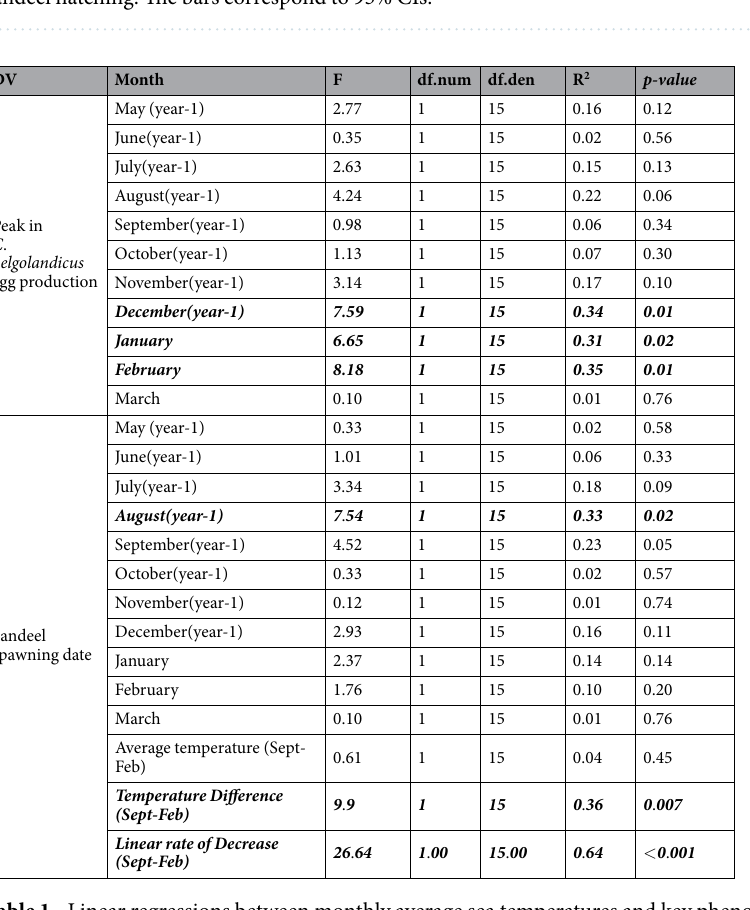
Figure 1. Inter-annual variations in C . helgolandicus and sandeel phenology. The mismatch measure is indicated by the dotted line between the median day of C . helgolandicus egg production and the median day of sandeel hatching. The bars correspond to 95% CIs.